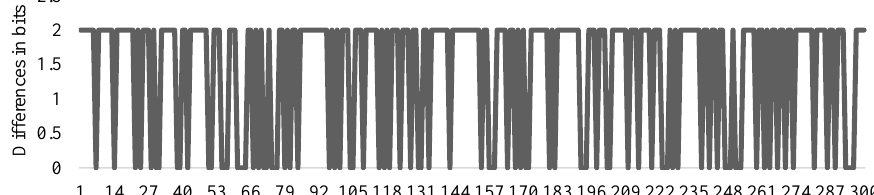
Figure 7. Balance Figure 7. Balance analysis.